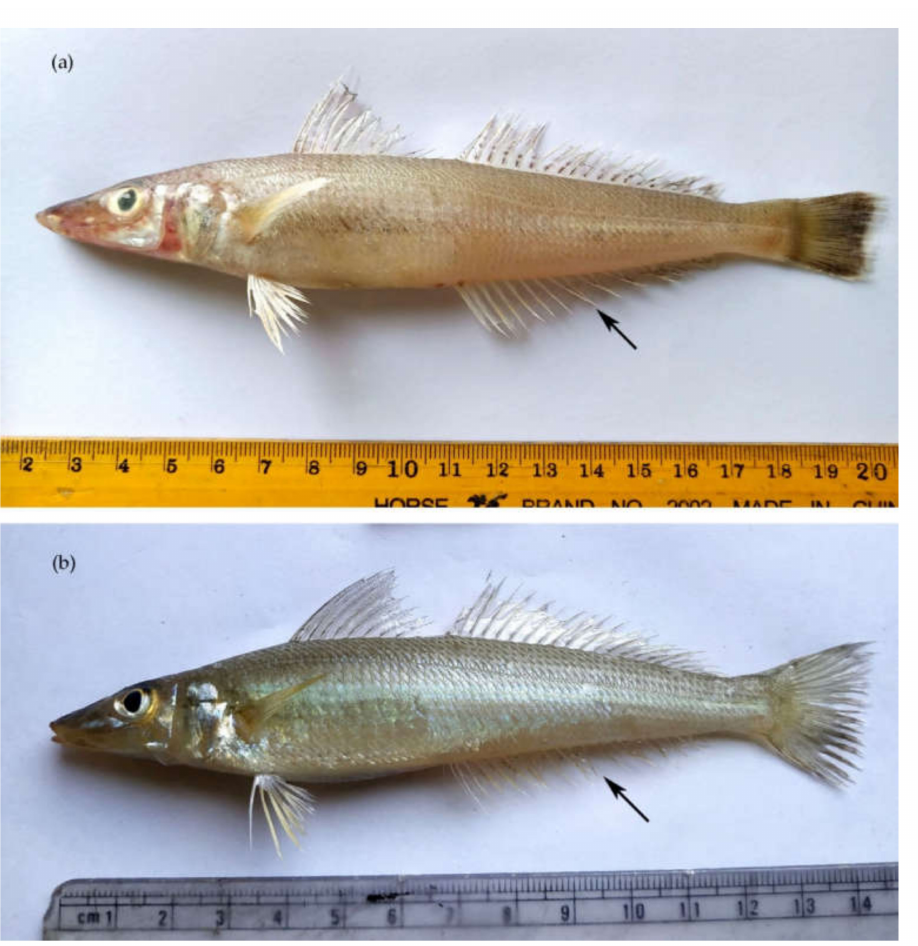
Figure 2. Two Sillago spp. nov. from the Bay of Bengal, Bangladesh. ( a ) S. muktijoddhai sp. nov., DS1201, paratype, 157.84 mm standard length (SL); ( b ) S. mengjialensis sp. nov., CO219110, paratype, 125 mm SL. Table 1. Morphomeristic characters of two Sillago spp. nov. from the Bay of Bengal,